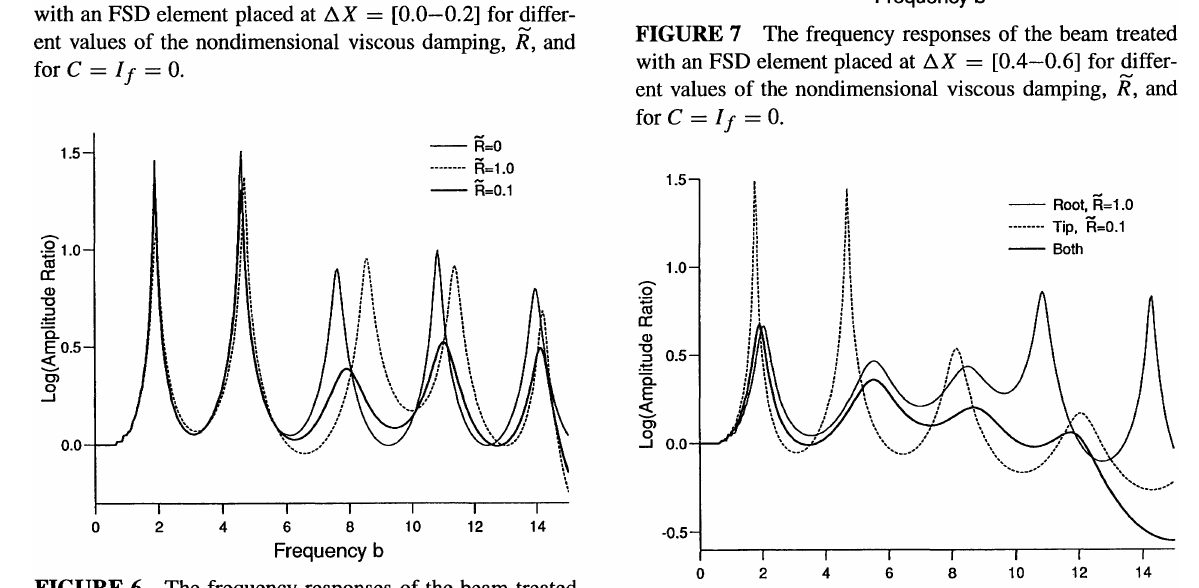
FIGURE 6 The frequency responses of the beam treated with an FSD element placed at fl.X = [0.2-0.4] for differ ent values of the nondimensional viscous damping, ii, and forC = If = O.